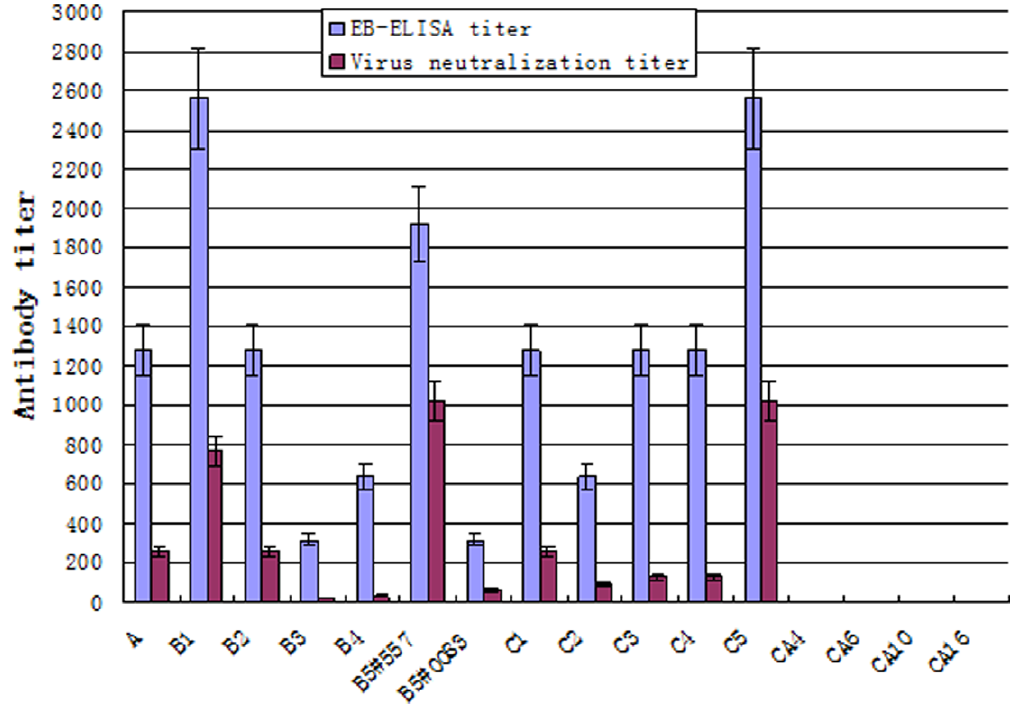
Figure 3. Sensitivity and specificity of the EB-ELISA. Performance of the EB-ELISA with sera from guinea pigs immunized with different strains of EV71 or mice with different coxsackievirus. Sera were collected 14 days after the 2nd immunization and normalized to a virus neutralization titer of 16 before the EB-ELISA. Inhibition above the cut-off value of 30% blocking was considered as positive; i.e. antibodies to EV71 were present. The results were expressed as the arithmetic mean of percent blocking values (n=4/group, whiskers above bars represent the standard error of the mean). NS: Normal preimmune serum; GP: guinea pig; MS: mouse. Dotted line: cutoff values.